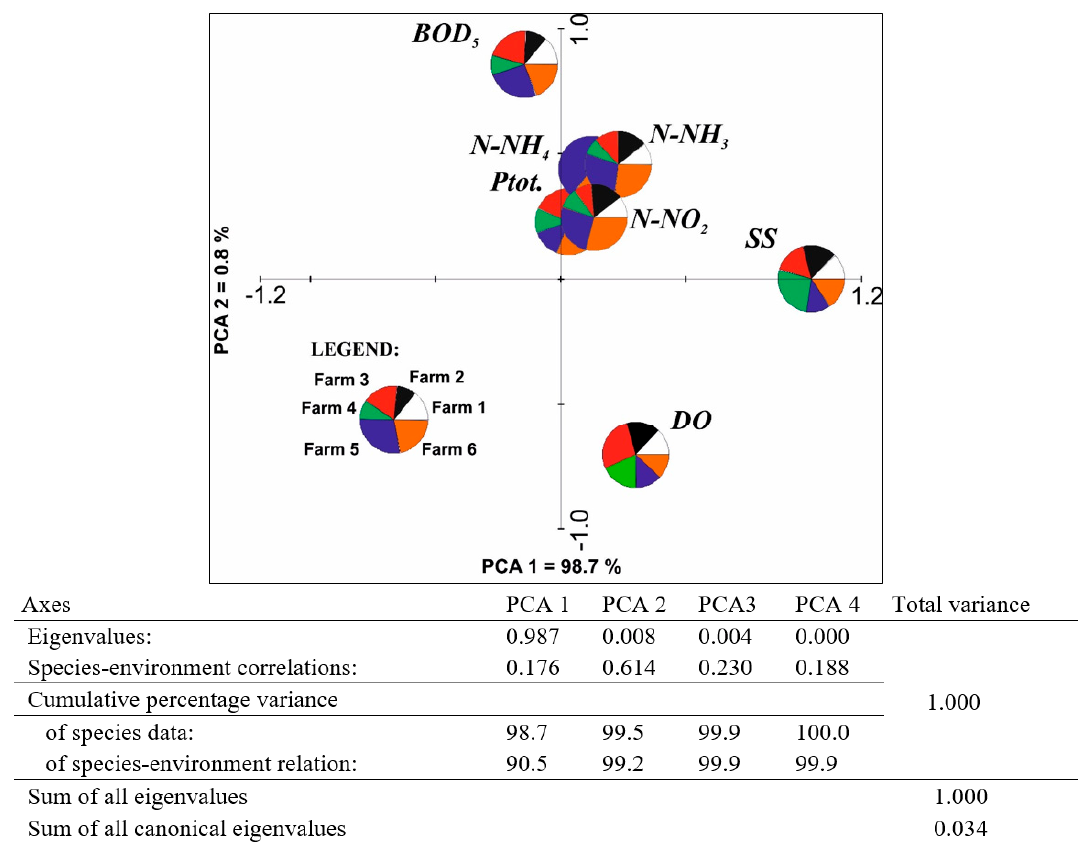
Figure 5. Principal component analysis of correlations between concentrations of selected substances in waters outflowing from trout ponds.